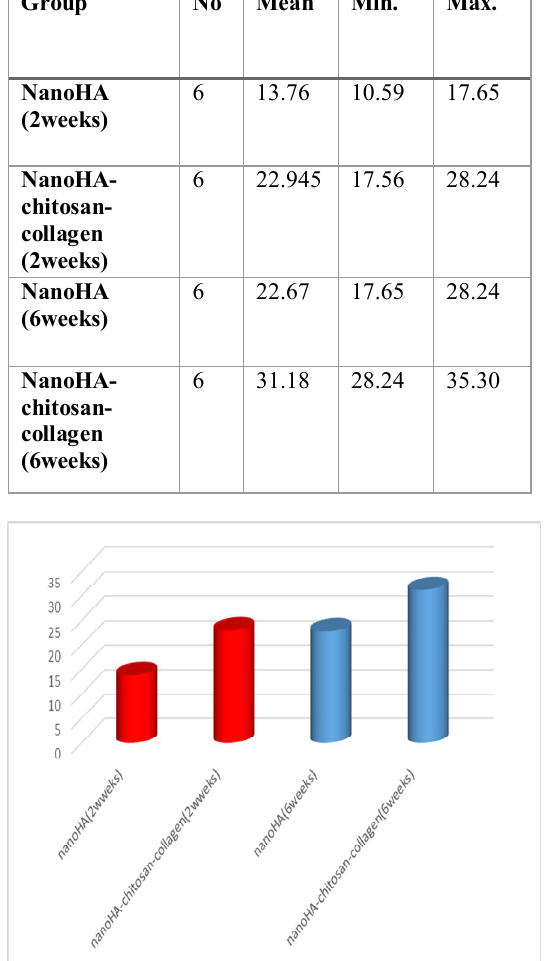
(Figure 7): Bar chart of summery of differences in the removal torque means values between all groups.